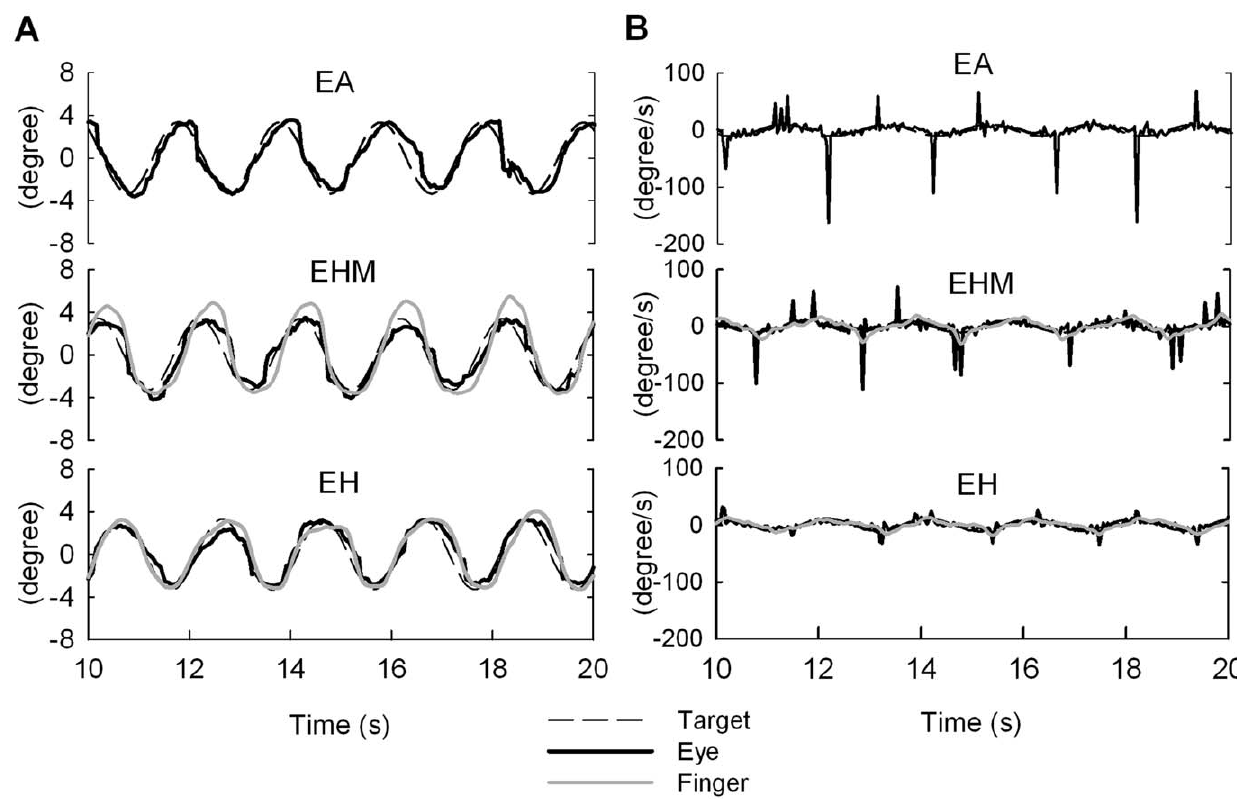
Figure 2. Raw data plots. Central 10 seconds of data of finger action and eye movement from a typical subject under the three tracking conditions. (A) Displacement traces, (B) velocity traces.